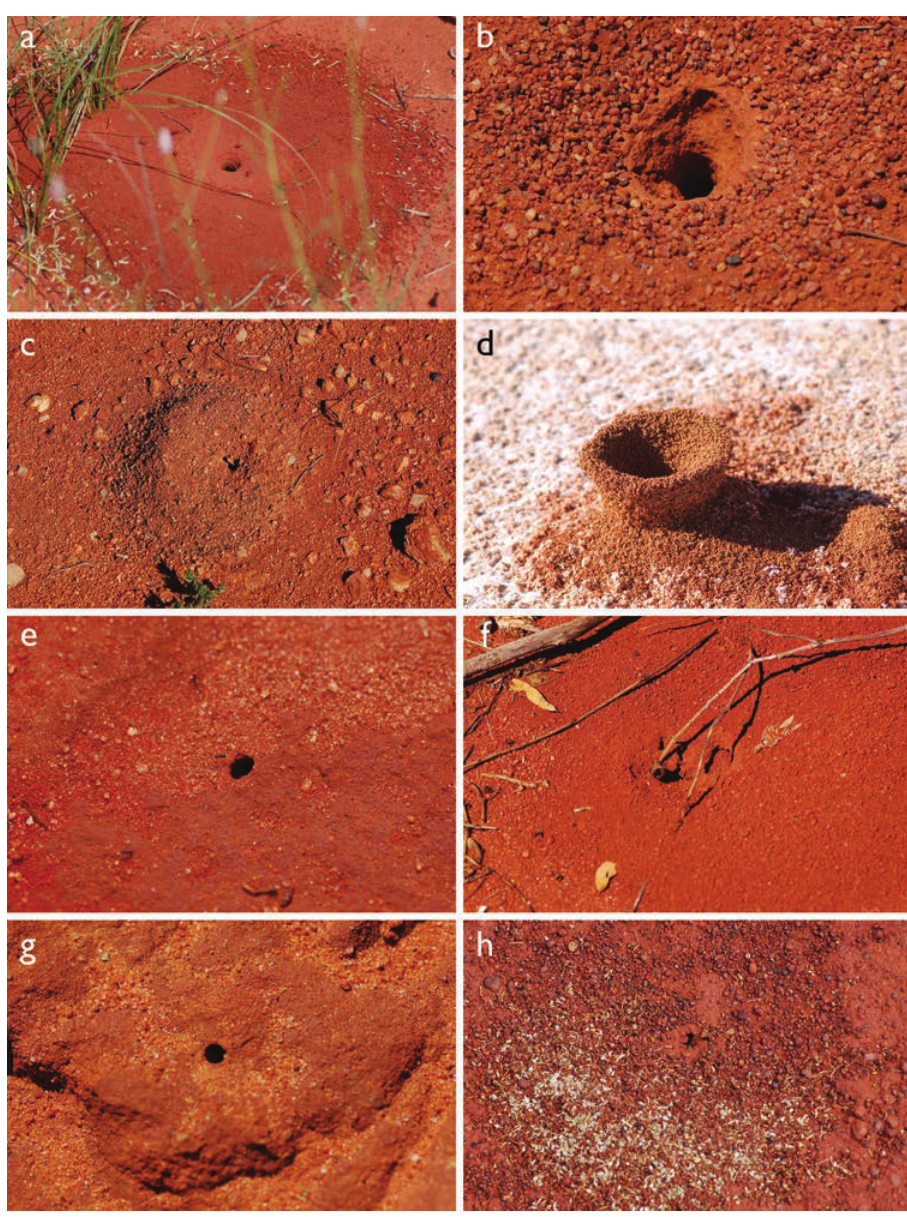
Figure 1. Melophorus nest entrances. a M . bagoti b M. gracilipes c M. longipes d M. marmar e M . mjobergi f M . perthensis g M . sulla , and h M . wheeleri . rus species have a strong preference for elaiosomes, the nutrient rich appendages found on the seeds of many Australian plants. Elaiosome-eating species such as M . perthensis are likely to play an important role in native seed germination (Majer et al.